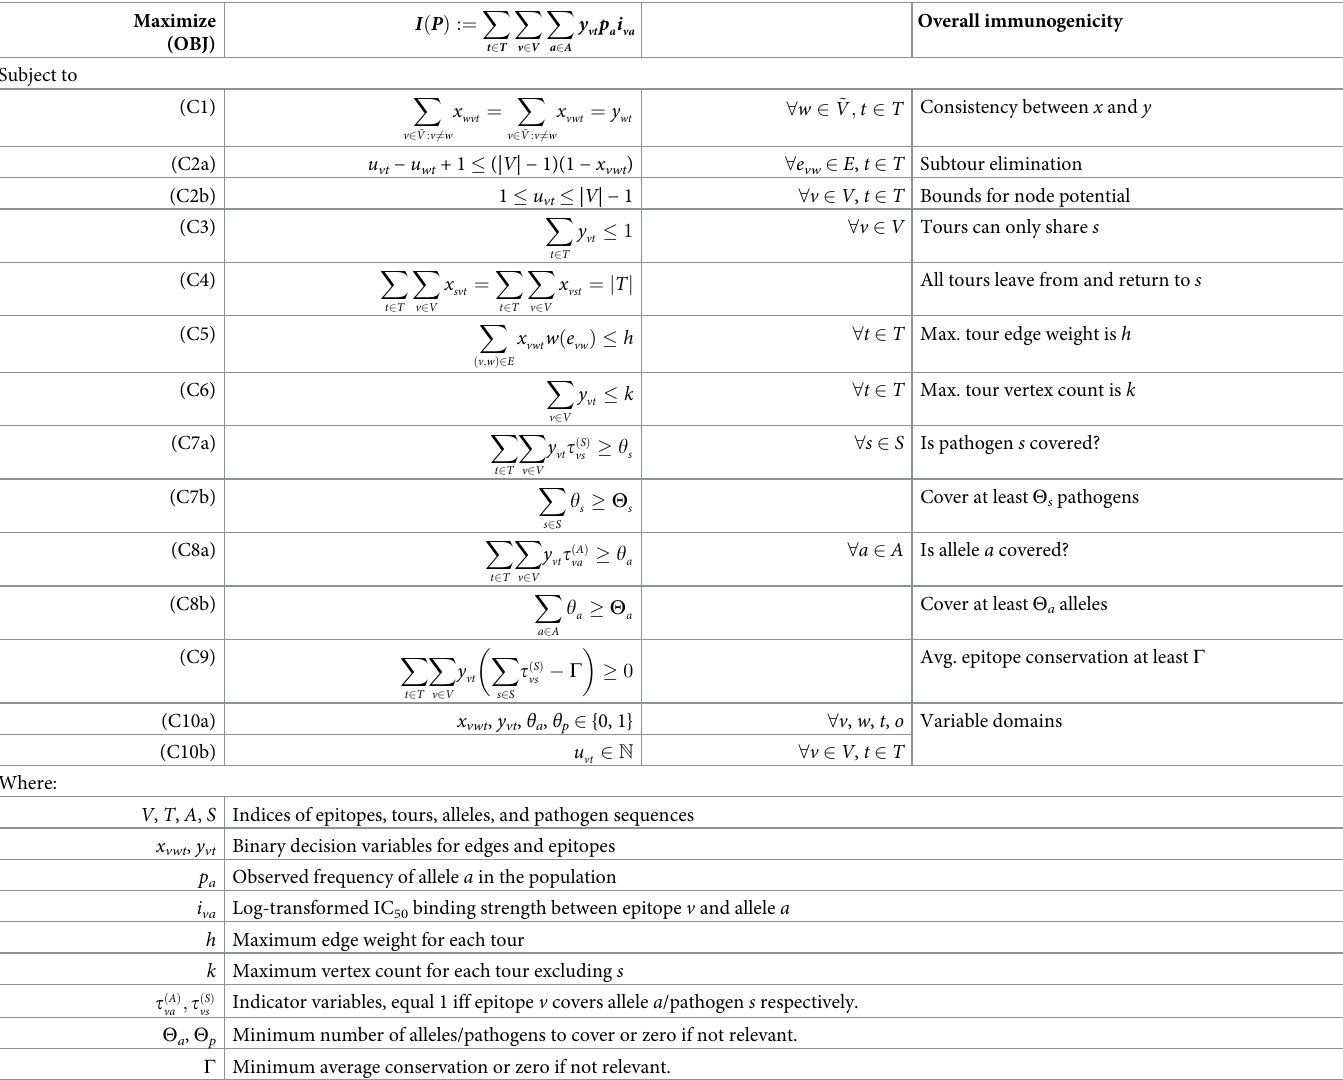
Table 1. Integer linear program formulation of the generalized epitope vaccine design problem. It results in a cocktail of | T | polypeptides each composed of at most k epitopes. Together, the polypeptides cover at least Θ s pathogens and Θ a MHC alleles, and contain epitopes with an average pathogen conservation of at least Γ . Maximize